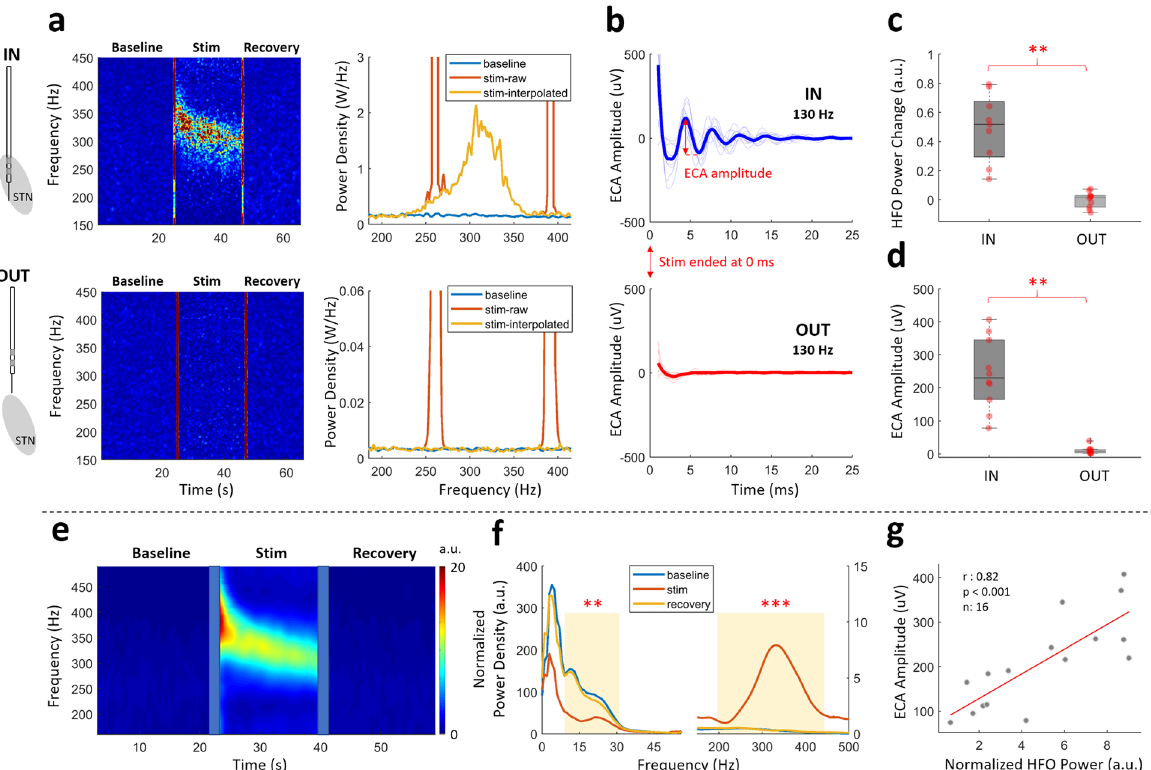
Fig. 2 High-frequency oscillations (HFO) and resonant evoked compound activity (ECA) are observed during high-frequency DBS only in the STN. a Representative TFM and PSD plots of out- and in-STN stimulation from a sample patient shows HFO was induced only within the STN. The vertical red lines on TFMs are the transition artifacts associated with turning the stimulator on and off. The large artifacts caused by harmonics of the stimulation frequency are interpolated. The color scale of the TFMs is the same as the limits of the y -axis of their respective PSD plots. b The evoked response waveform at the end of 22 s stimulation was only seen in-STN. The thick lines illustrate the mean waveform for all subjects. The fi rst 1 ms after the stimulation pulse is blanked out due to large artifact amplitude. c Comparison of the HFO power change between out- and in-STN stimulations show a signi fi cant difference ( n = 10). d Similarly, the difference between ECA amplitude of out- and in-STN stimulations was signi fi cant ( n = 10). e The grand average TFM from all 16 hemispheres with 130 Hz in-STN stimulation shows a stark enhancement in the HFO range, similar to the representative subject. The transition artifacts on TFM are masked with blue boxes. f The grand average PSD plots for baseline, stimulation, and recovery periods from all 16 hemispheres with high-frequency stimulation in-STN. There was a signi fi cant suppression in the beta and signi fi cant enhancement in the HFO ranges ( n = 16). g In the STN, the ECA amplitude and induced HFO power correlated ( n = 16). On each box in the boxplots, the central mark indicates the median, and the bottom and top edges of the box indicate the 25th and 75th percentiles, respectively. The whiskers extend to the most extreme data points not considered outliers, and the outliers are plotted individually using the “ + ” symbol. The individual data points are also plotted as red circles. ** denotes signi fi cance <0.01, *** denotes signi fi cance